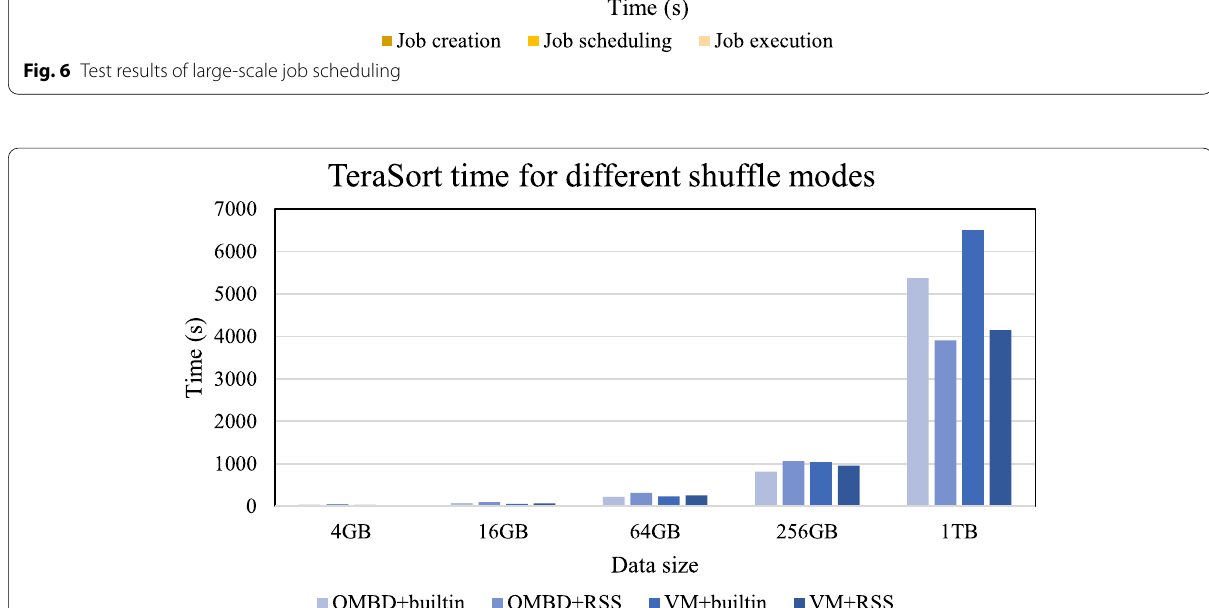
Fig. 7 Test results of distributed job